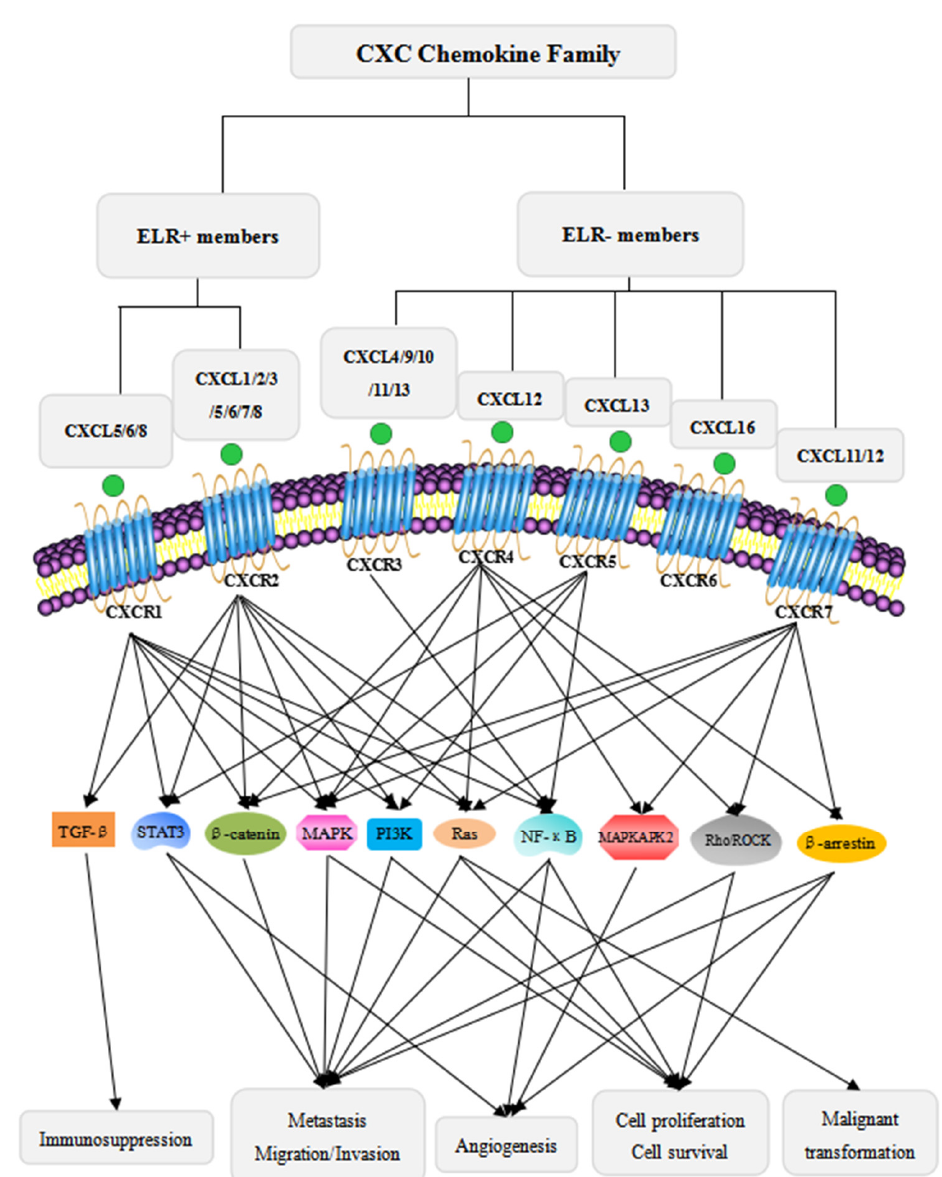
Figure 1. Classification of the CXC chemokine family and the major signaling pathways of CXC chemokines in cancer progression. The CXC chemokine family is divided into two subtypes: ELR+ members and ELR- members [21–23]. ELR+ members bind to CXCR1/2 [21,26], and ELR- members bind to CXCR3/4/5/6/7. ELR+ members promote tumor progression through multiple signaling pathways. The ELR+ CXCLs/CXCRs axes specifically activate TGF- β signaling with immunosup- pressive activity [31]. Moreover, the ELR+ CXCLs/CXCRs signaling axes activate MAPK [14,32–34], PI3K/AKT [11,17,33], β -catenin [35], STAT3 [7,36], NF- κ B [8,27,37], and Ras [20] signaling path- ways to mediate tumor cells proliferation, metastasis, angiogenesis, and malignant transformation. Although ELR- members mainly have anti-tumor activity, some ELR- members have dual roles in cancer progression. The ELR- CXCLs/CXCRs axes activate MAPKAPK2 signaling to enhance angiogenic activity [38], Rho/ROCK signaling to increase metastatic tendencies and immortal pro- liferation [39,40], and β -arrestin signaling to promote metastasis, immortal pro iferation and angio- genesis [41]. In addition, ELR- members, similar to ELR+ members, also activate MAPK [40,42–44], PI3K/AKT [40,42,44,45], β -catenin [46], STAT3 [47], NF- κ B [30], and Ras [43] signaling